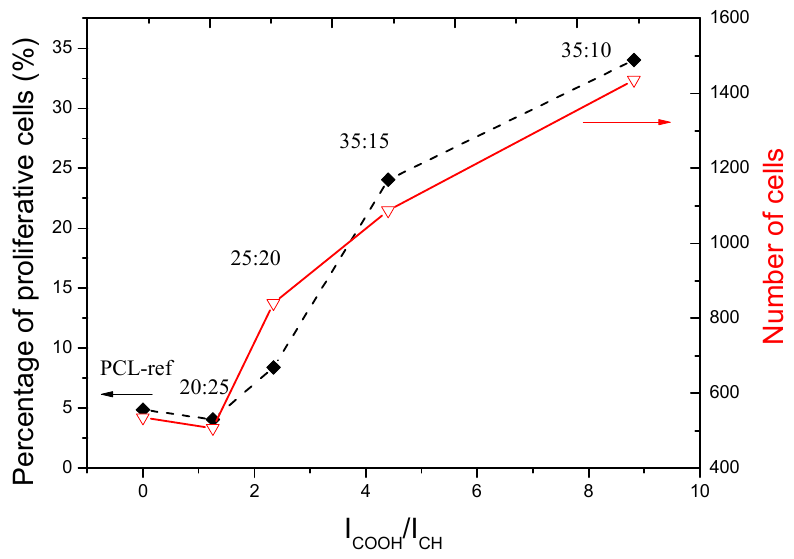
Figure 13. The plot of cell numbers and percentage of proliferating cells as a function of I C=O /I CH ratio.